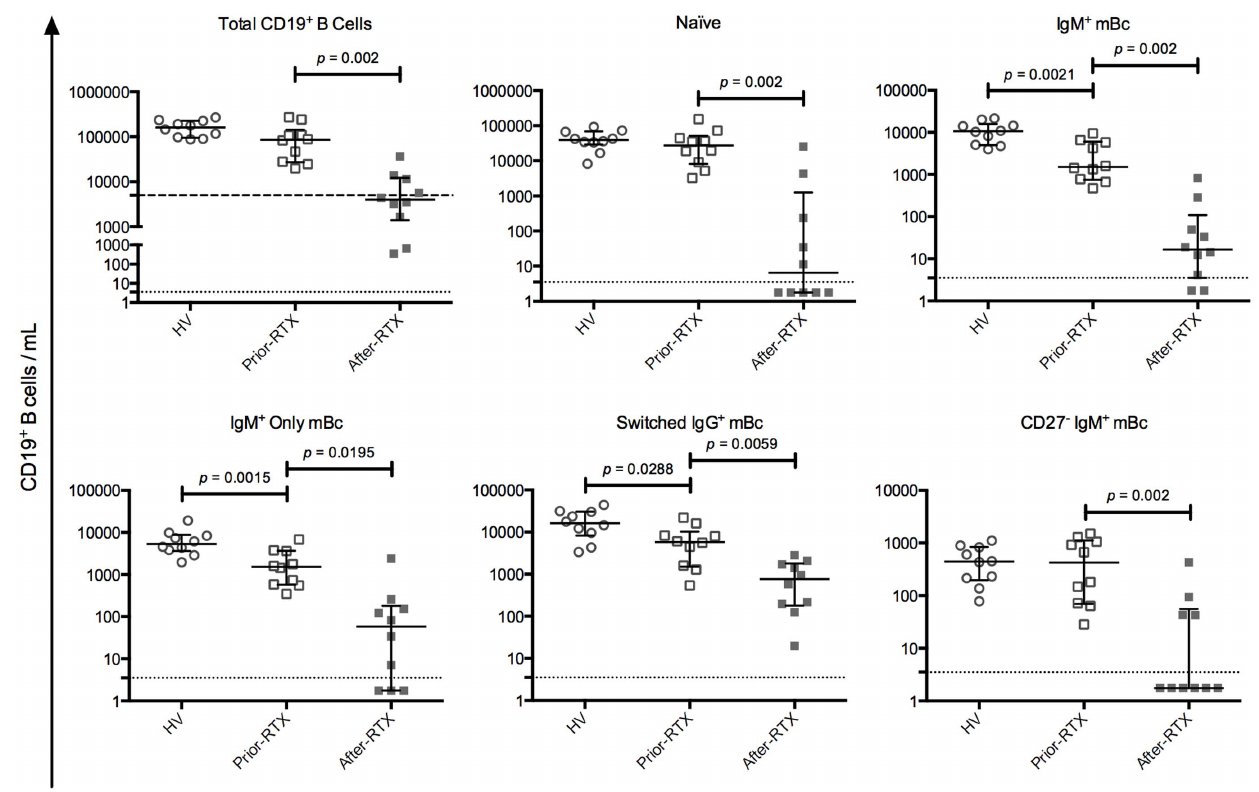
Figure 2. Comparison of selected total B cell subpopulations among the study groups. Healthy volunteers (HV) (n=10), patients before RTX treatment (prior-RTX) (n=10) and patients after RTX treatment (after-RTX) (n=10). For total CD19 + B cells, the dashed line represents the clinical depletion limit after RTX treatment (less than 5,000 CD19 + cells/mL). The dotted lines represent the estimated flow cytometry detection limit of 3.5 CD19 + B cells/mL. Solid lines and error bars denote the median and interquartile range, respectively. Differences between HV and patients prior-RTX were evaluated with Mann–Whitney tests and between patients prior-RTX and patients after-RTX with Wilcoxon tests. All p values reported are 2- tailed.